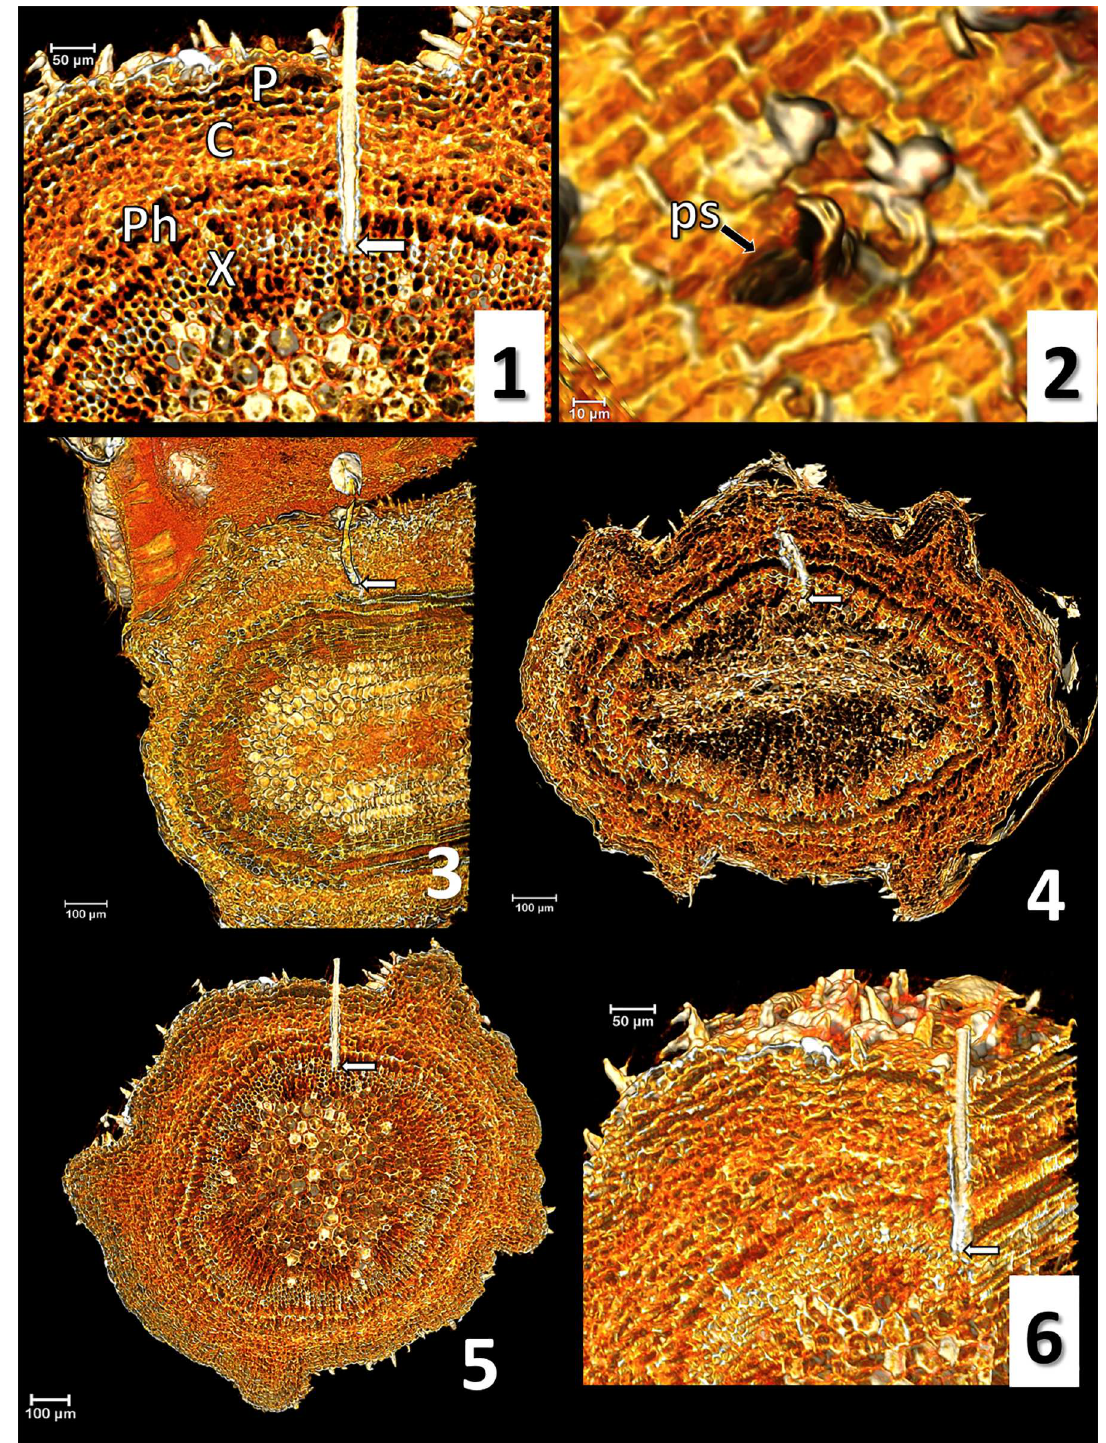
Fig 1. Micro-CT volume rendering reconstruction images and correlation waveform/stylets position. 1) olive anatomy: P (periderm), C (cortex), Ph (phloem), X (xylem) (nomenclature according to Ruiz et al. [45]); 2) probing site (ps); 3) waveform C; 4) waveform Xc; 5) waveform Xi; 6) Xi, lateral view. White arrows indicate the stylets tip.